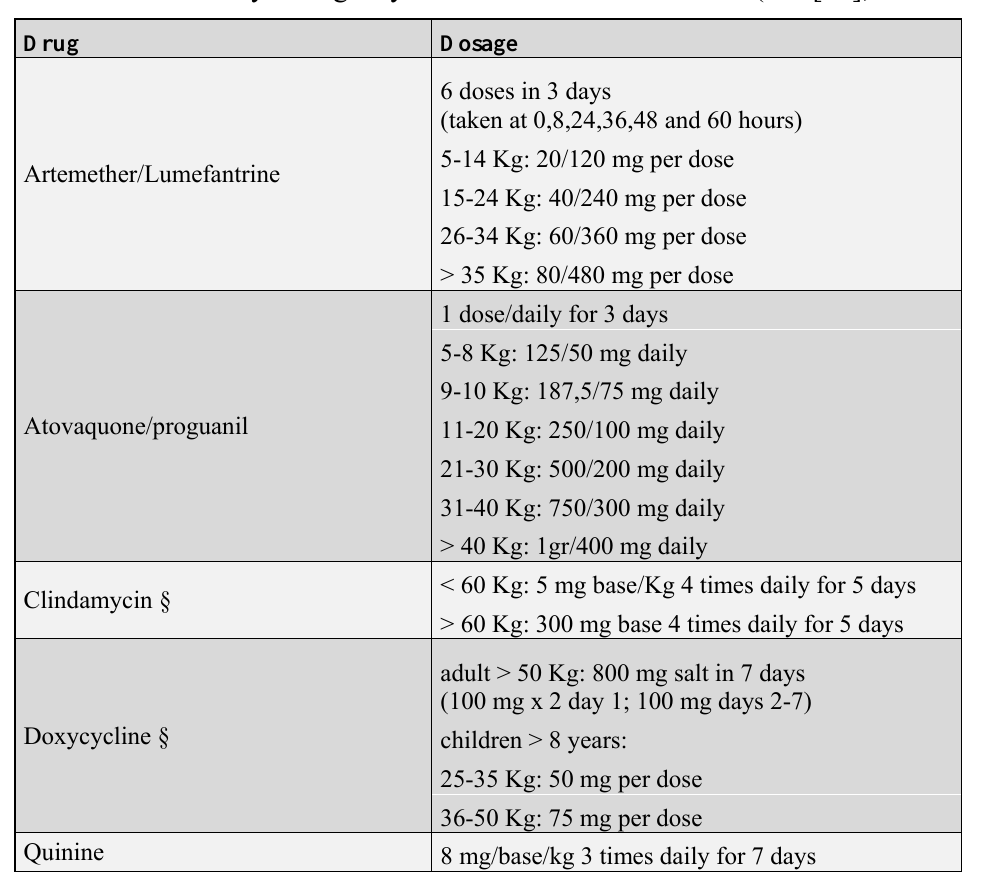
Table 5. WHO stand-by emergency treatment recommendations (ref. [90],